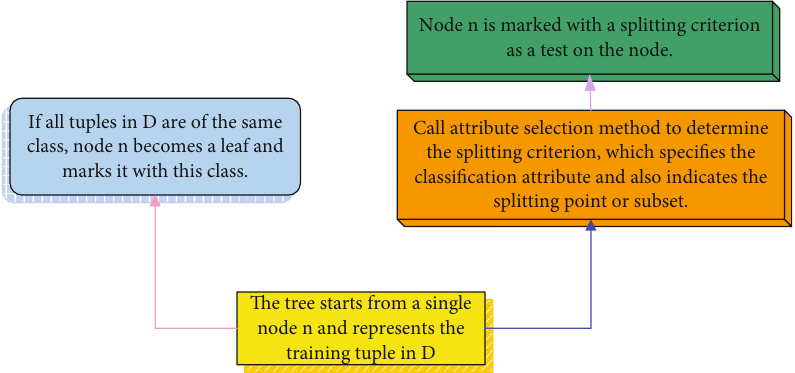
Figure 4: Decision tree algorithm.